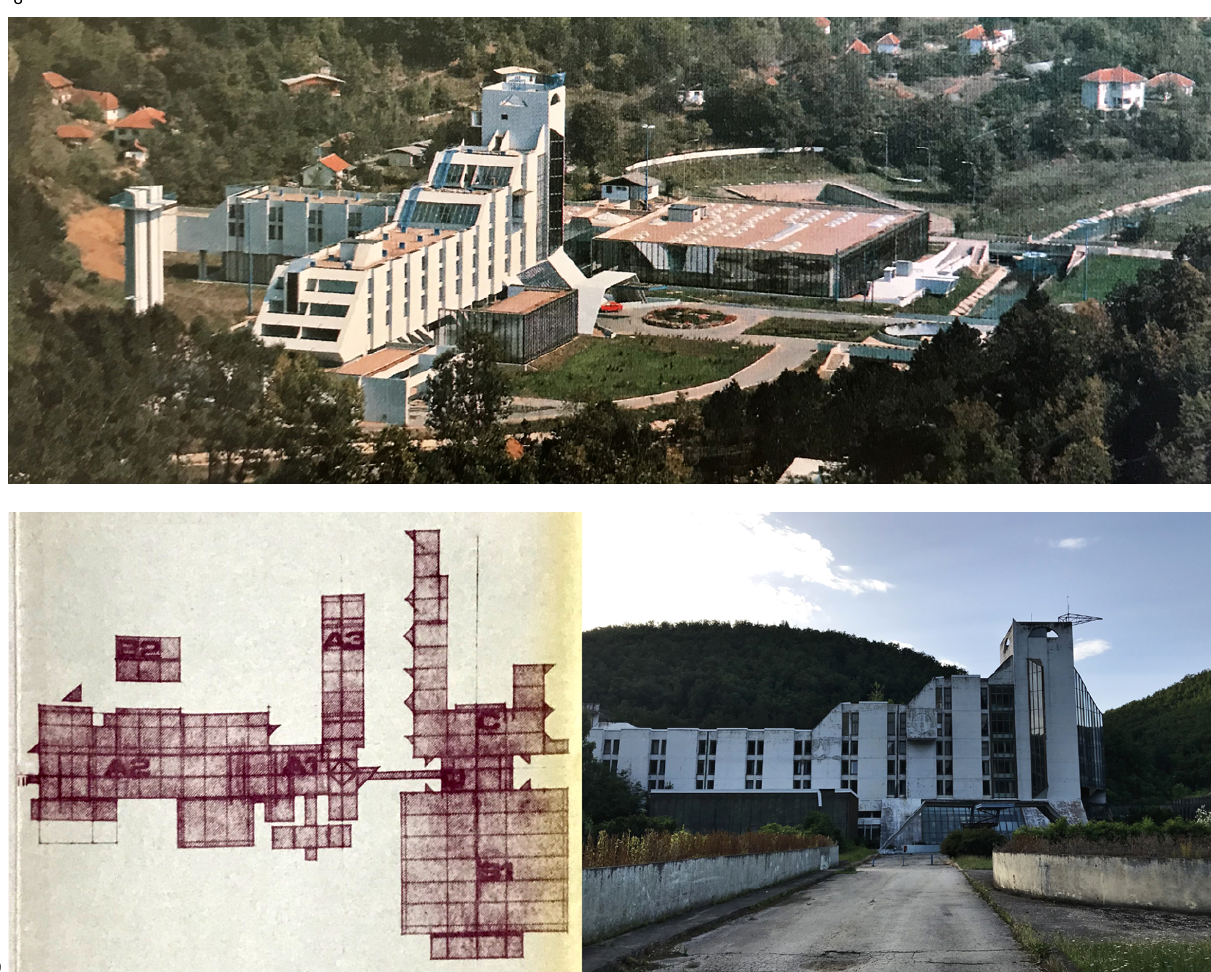
Fig. 8 Franc Avbelj et al., Medical and Recreational Center Žubor in Kuršumlija Spa After Its Con- struction (1976-1982) (Source: Private Archive of Đ. Eraković in Kuršumlija, Serbia) Fig. 9 Franc Avbelj et al., Medical and Recreational Center “Žubor” in Kuršumlija Spa (1976-1982), Scheme of the Floor Plan (left) and Front Facade (right) (Sources: Planika Company Archive in Kuršumlija, Serbia (left). Copyright Aleksandra Jevtović, 2019